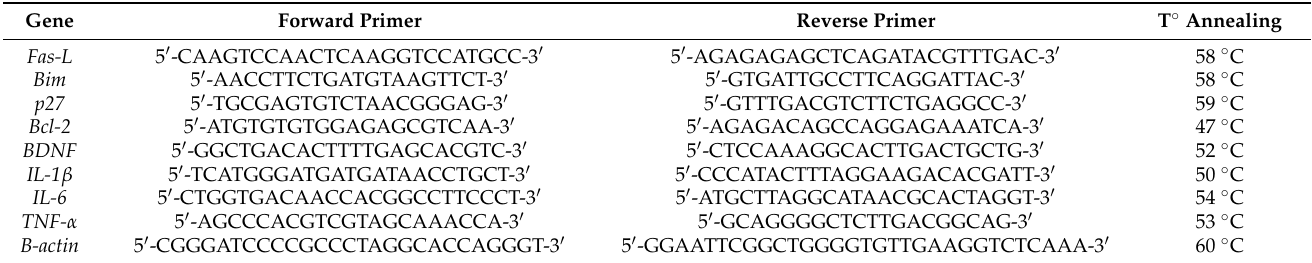
Table 1. Oligonucleotide sequence of primers for